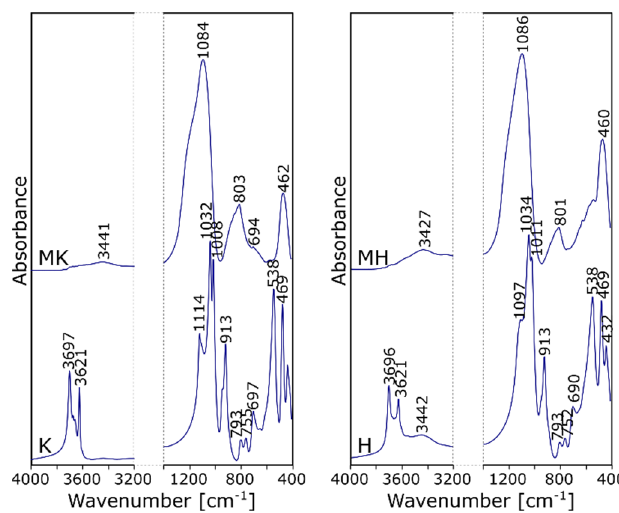
Figure 2. The mid-infrared (MIR) spectra of initial clays ( K = kaolin ( left ) and H = halloysite ( right )) and clays after the calcination at 700 ◦ C ( MK = metakaolin ( left ) and MH = metahalloysite ( right )).